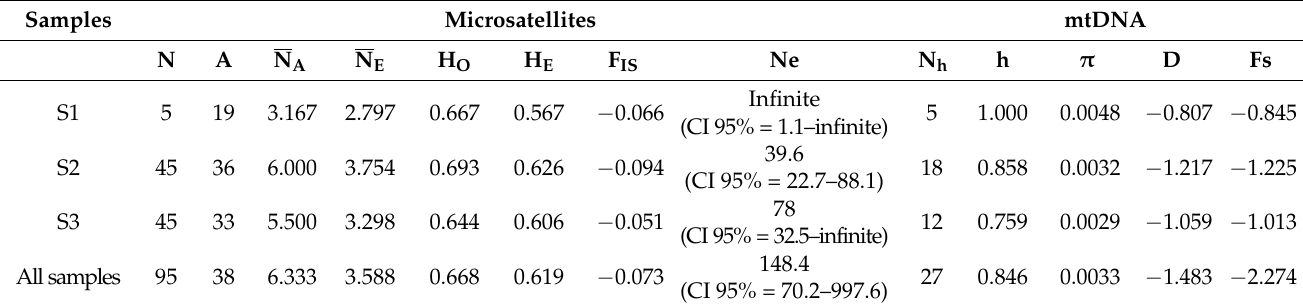
Table 1. Genetic diversity and effective population size of Steindachneridion melanodermatum in three locations of the Lower Iguaçu River, based on microsatellite markers and mitochondrial haplotypes (D-